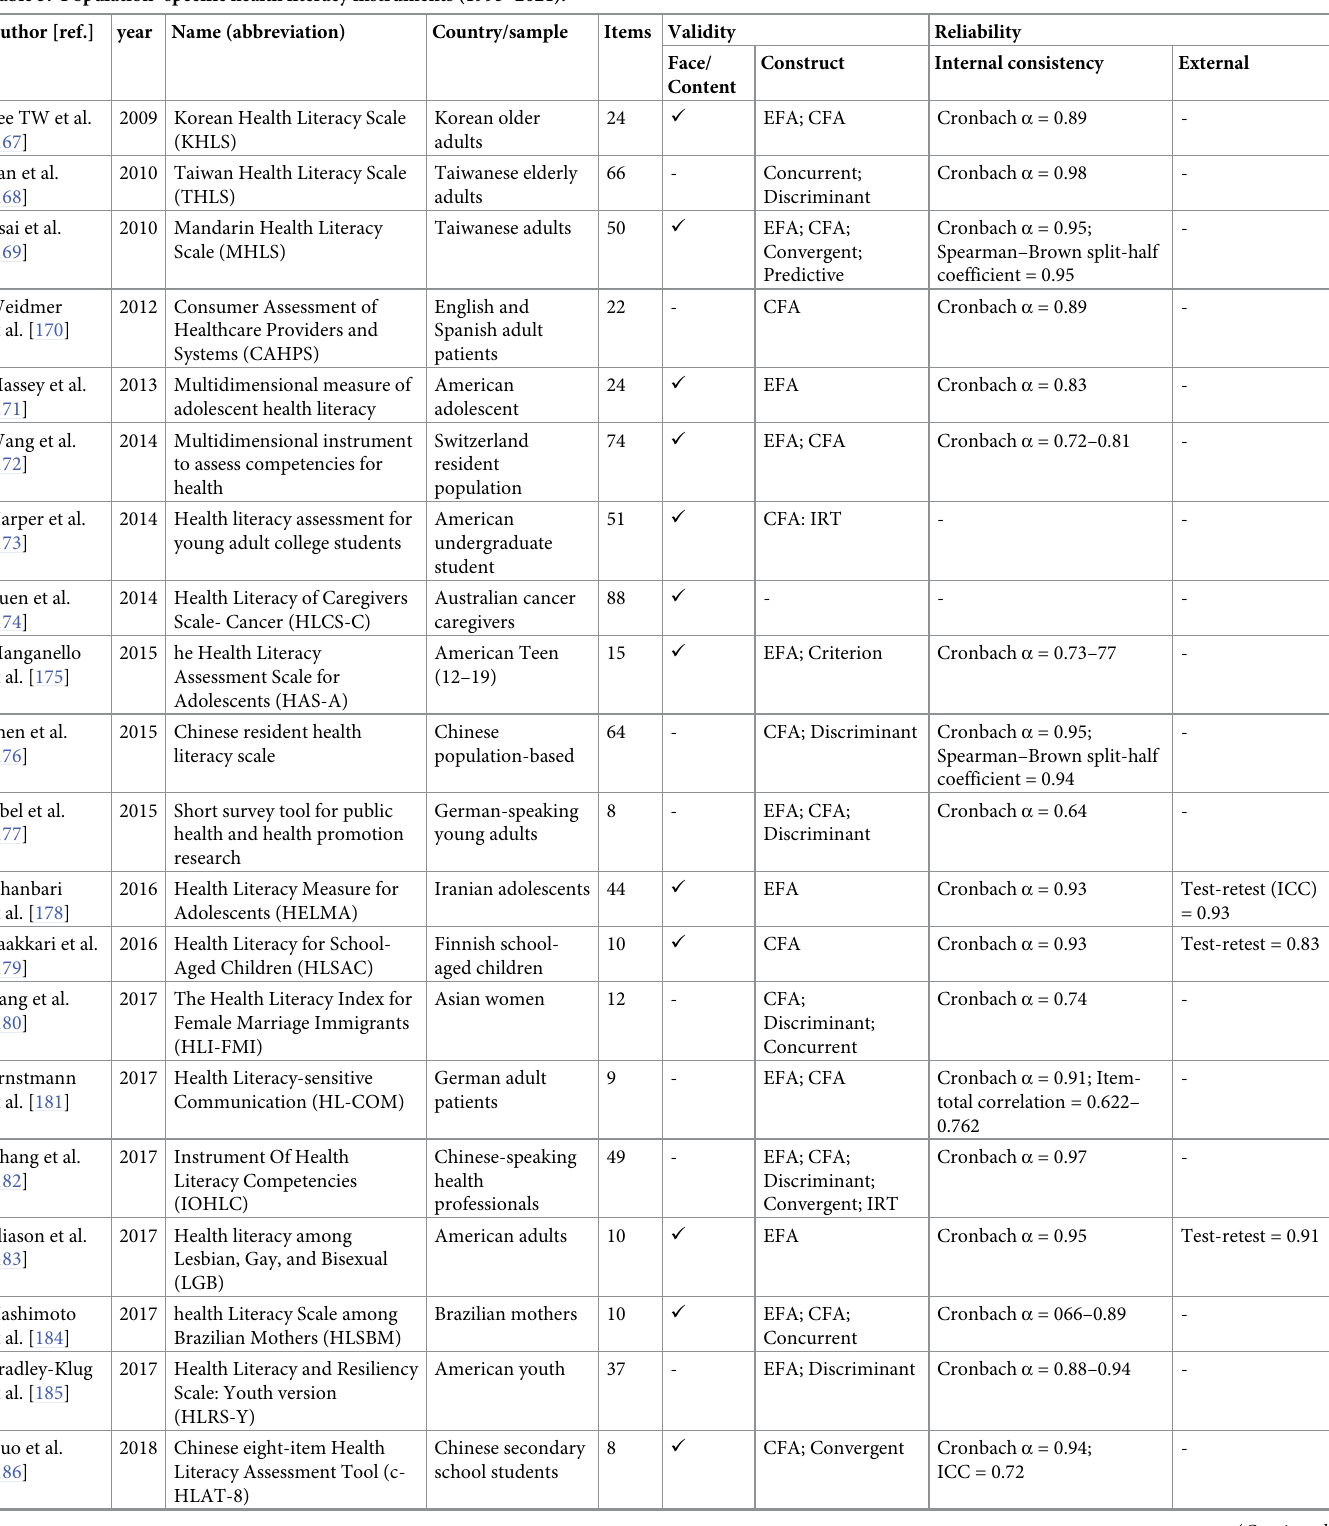
Table 5. Population- specific health literacy instruments